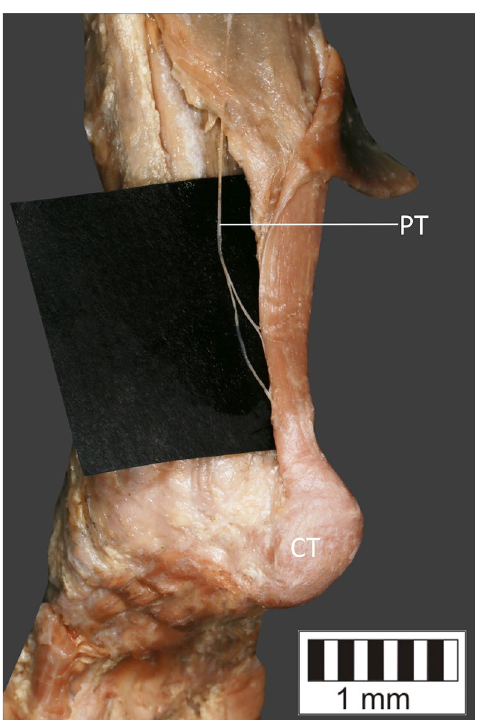
Figure 10. Type VII of plantaris tendon. PM ended with two bands both of which terminated in the Achilles